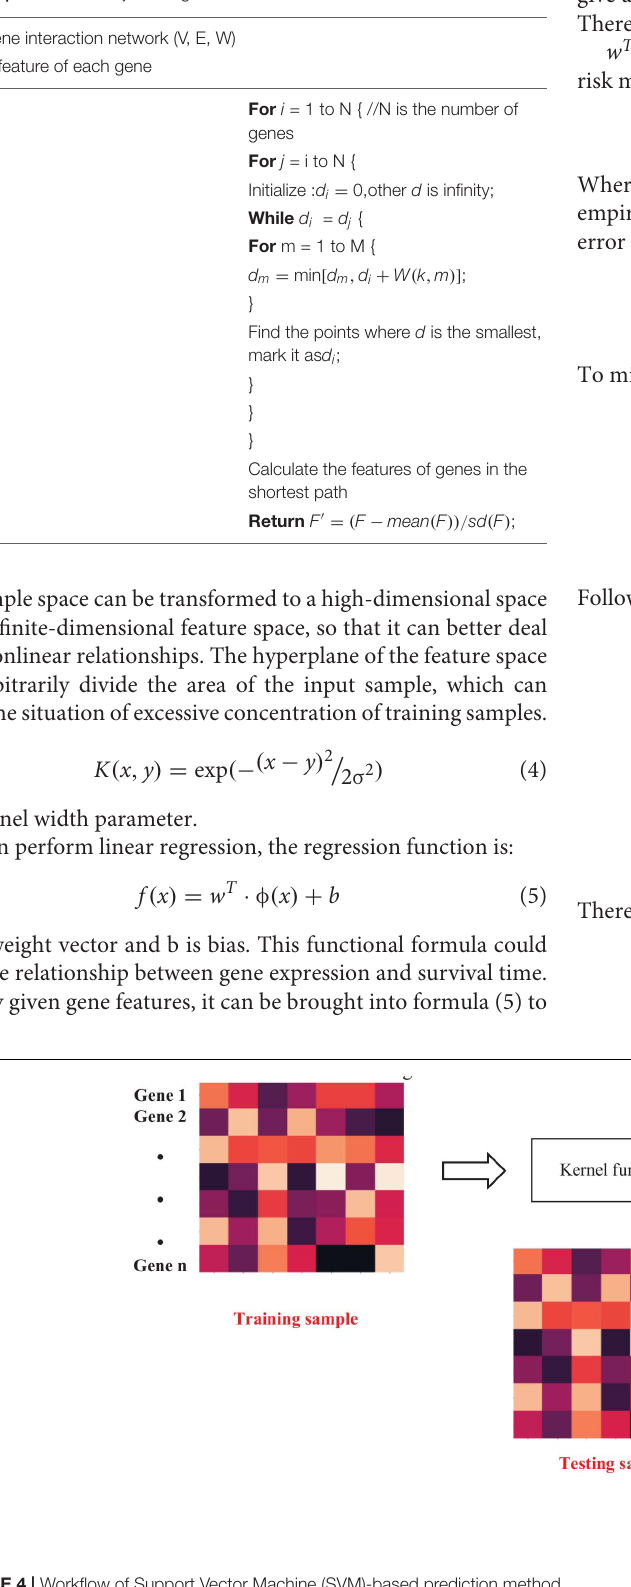
TABLE 1 | Workflow of Dijkstra algorithm.